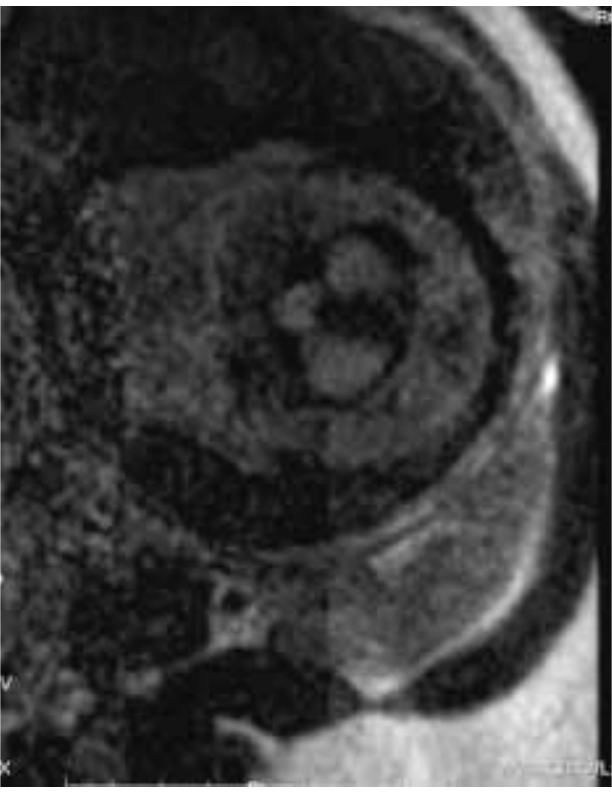
Fig. 1. Case 1: Axial fetal MRI: Splayed hypoplastic cerebellar lobes, and an enlarged cisterna magna and vermian agenesis consistent with a Dandy- Walker